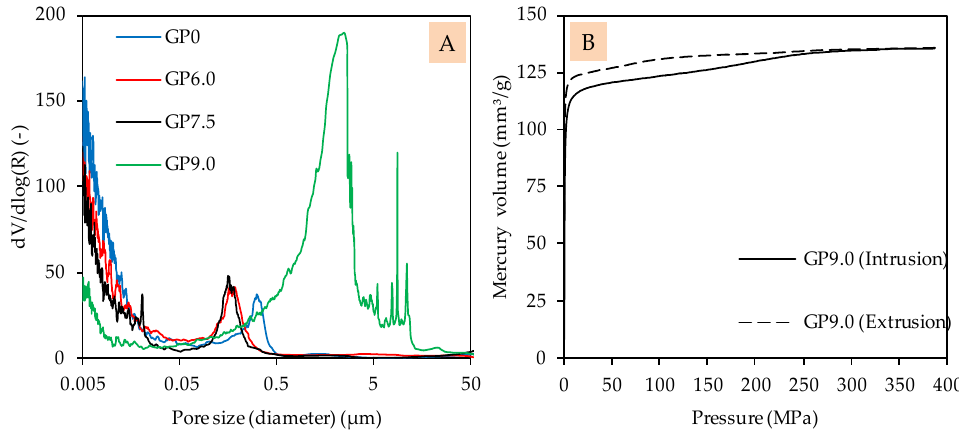
Figure 6. Pore size distribution of geopolymers after 28 days of curing ( A ) and pressure-dependent mercury volume in sample for intrusion and extrusion of GP9.0 after 28 days of curing ( B ).